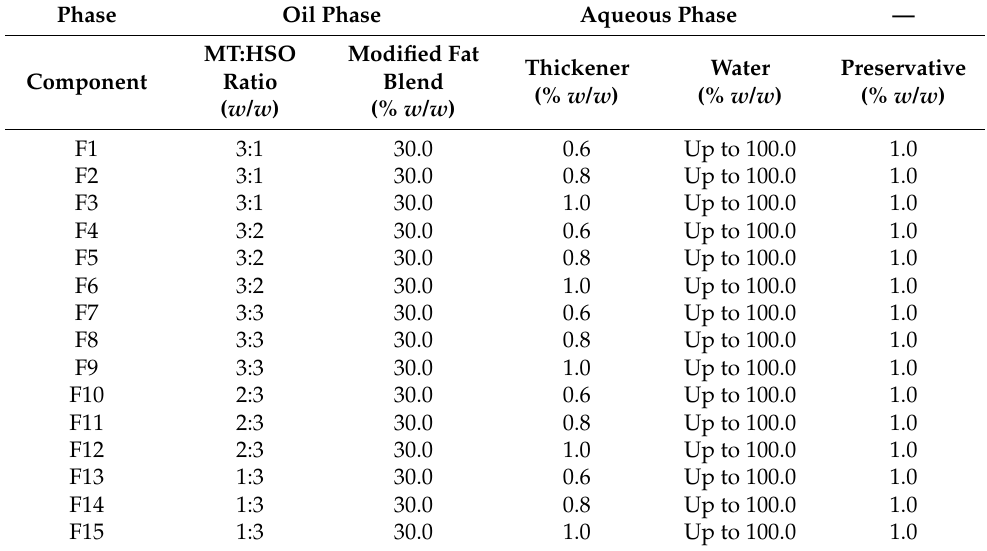
Table 1. Formulation of the